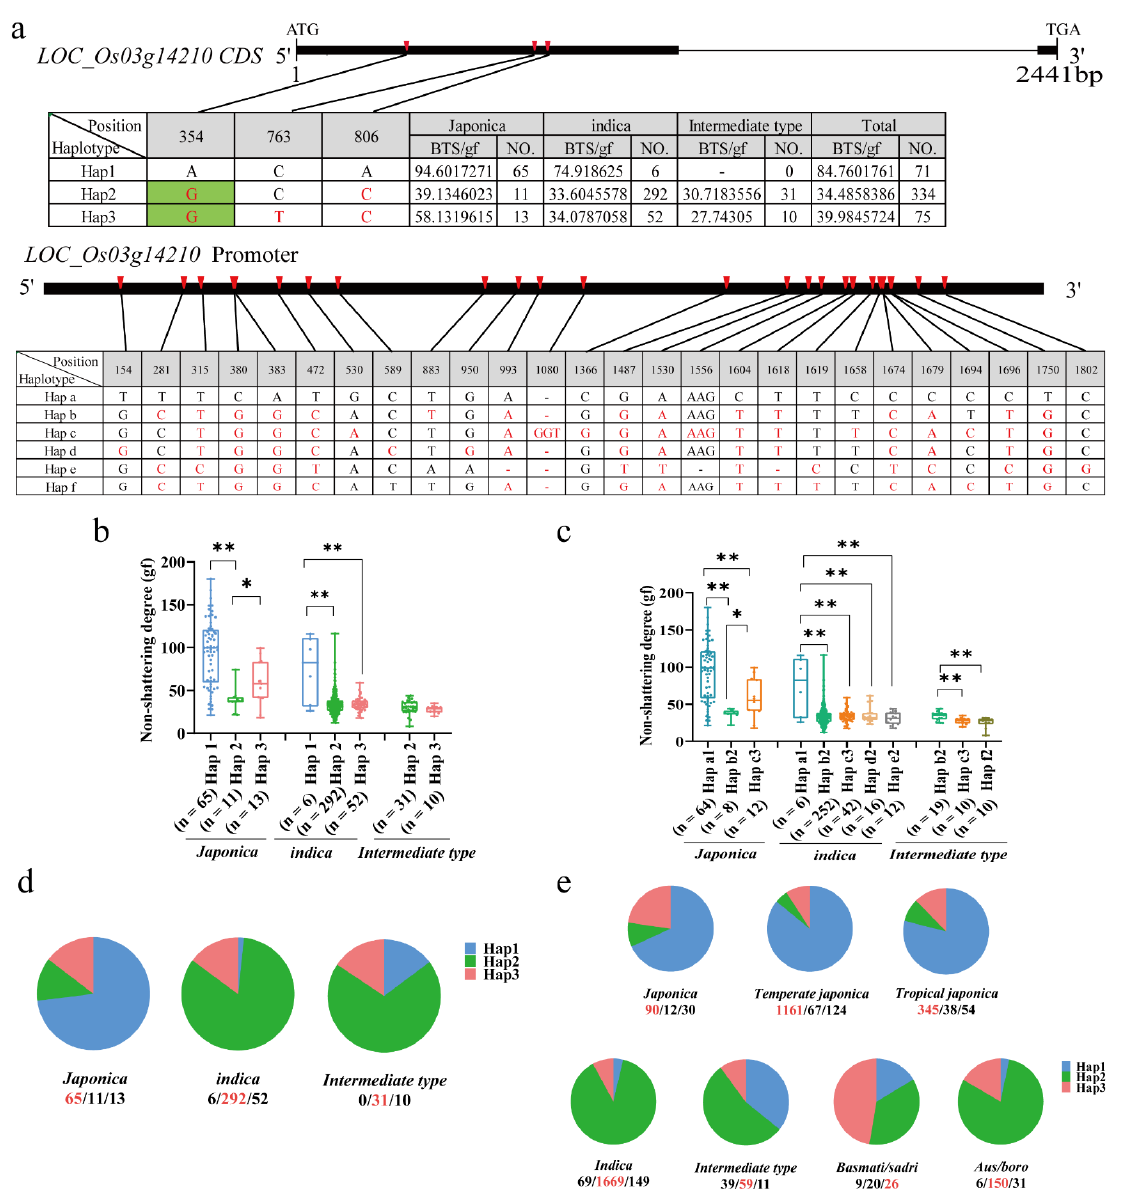
Figure 9. Candidate gene analysis of qBTS3 : ( a ) Haplotype analysis of LOC_Os03g14210 coding re- gions in 480 naturally occurring rice cultivars. Red letters symbolize different nucleotides, and green-marked letters symbolize nonsynonymous substitutions. ( b ) Haplotype analysis of the candidate gene LOC_Os03g14210 in 480 natural rice cultivars (coding sequence (CDS) regions); ** indicates an extremely significant difference at the 1% level. * indicates a significant difference at the 5% level. ( c ) Haplotype analysis of the candidate gene LOC_Os03g14210 in 451 natural rice cultivars (coding sequence (CDS) regions and promoter); ** indicates an extremely significant difference at the 1% level. * indicates a significant difference at the 5% level. ( d ) Distribution frequency of the five LOC_Os03g14210 haplotypes in 480 naturally occurring rice cultivars. The numbers of the cultivars with the haplotypes are given